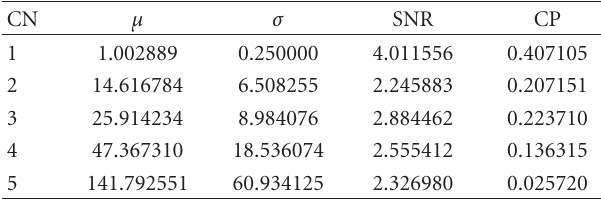
Table 5: Statistical information about the best class number for the simulated phantom data set, tumour